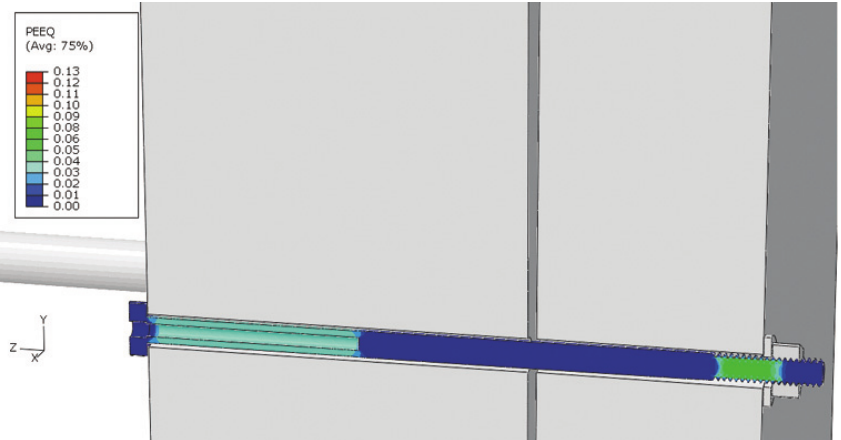
Fig. 15. Contours of equivalent plastic strain, dynamic tension model, t = 24 ms.